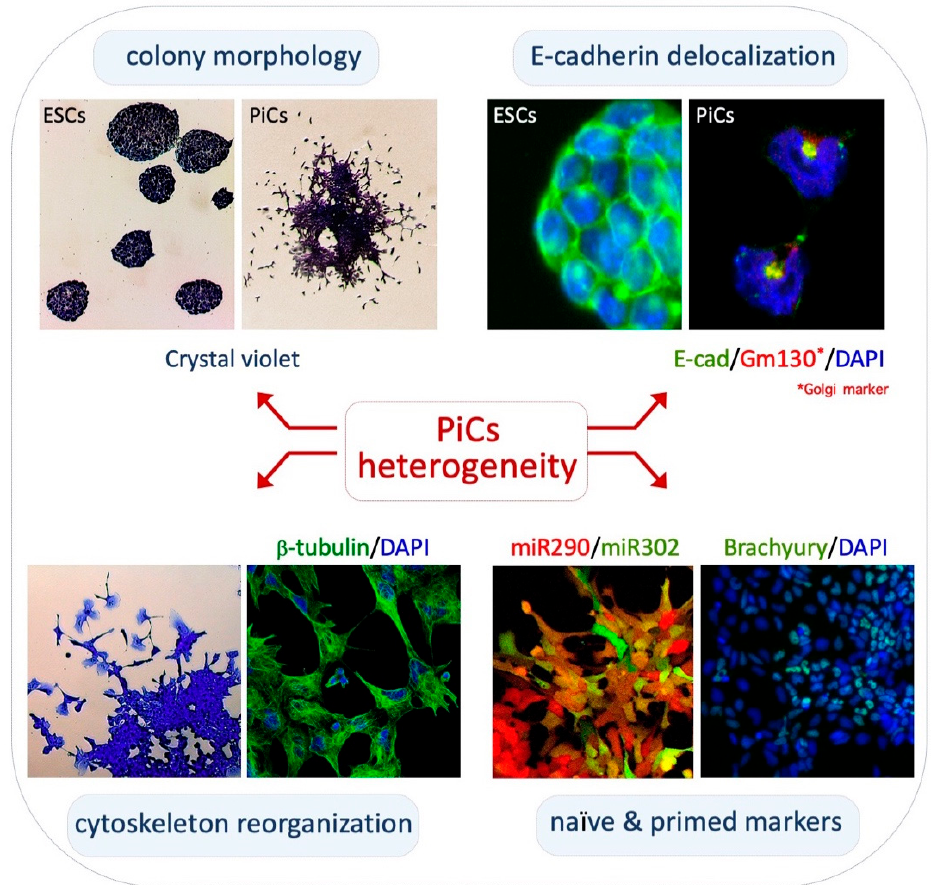
Figure 1. Phenotypic heterogeneity of PiCs. Top left , crystal violet staining highlights the irregular/heterogenous structure of PiC colonies. Top right , immunofluorescence analysis showing the different localization (cell membrane vs. perinuclear structure) of E-cadherin protein (green) in naïve ESCs and motile PiCs. Bottom left , motile PiCs show a mesenchymal-like morphology with prominent filopodia and lamellipodia and a fibrillar cytoskeleton. Bottom right , expression of miR-290/mCherry and miR-302/eGFP ( left ) in PiCs derived from dual reporter ESCs (DRES) and immunostaining for Brachyury ( right ) in PiC